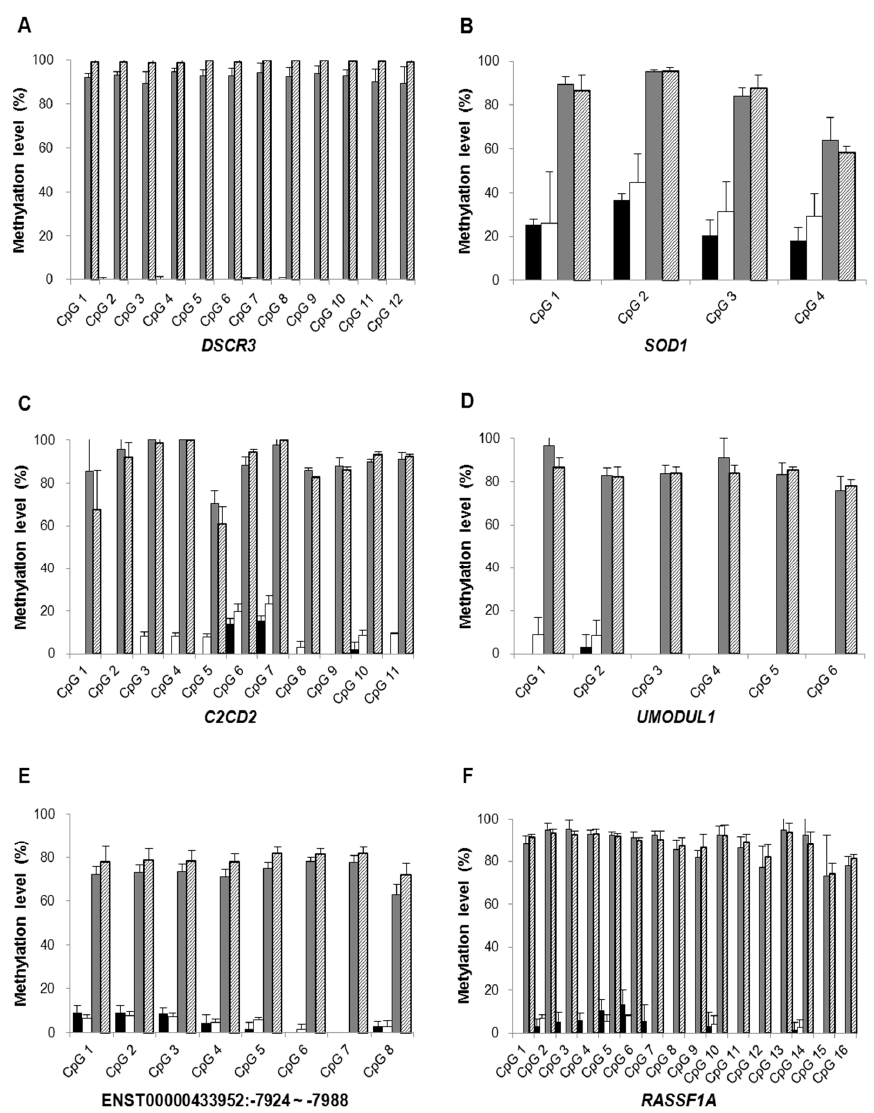
Figure 2. DNA methylation levels of each CpG site in DSCR3 , SOD1 , C2CD2 , UMODL1 and ENST00000433952:-7924–-7988 regions selected from array data and RASSF1A region by bisulfite direct sequencing. The methylation levels each CpG site of these 5 regions and RASSF1A region quantified in 8 pairs of maternal blood cells and placenta samples from PE and normal pregnancies: ( A ) DSCR3 ; ( B ) SOD1 ; ( C ) C2CD2 ; ( D ) UMODL1 ; ( E ) ENST00000433952:-7924–-7988; ( F ) RASSF1A . Data are presented as mean ± SE. Solid black bars, maternal blood cells from normal pregnancy; open bars, maternal blood cells from PE pregnancy; gray bars, placental tissues from normal pregnancy; stripes bar, placental tissues from PE pregnancy.